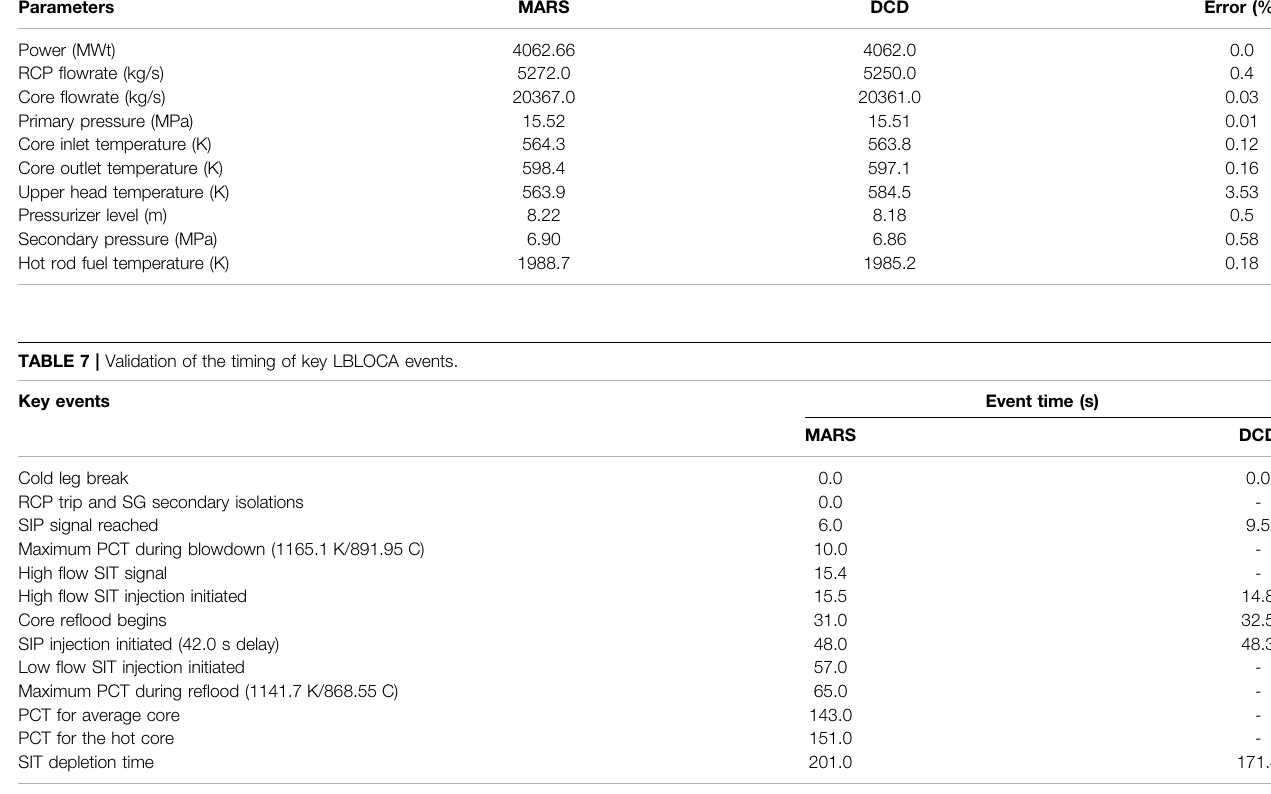
TABLE 6 | Validation of steady state analysis. Parameters